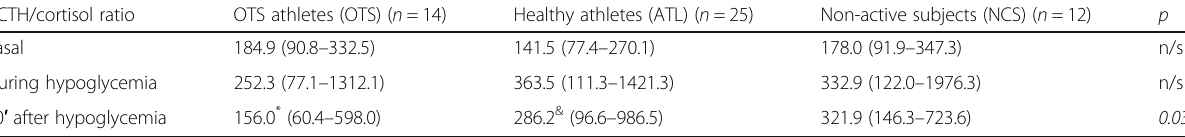
Table 4 Median (p95 confidence interval) ACTH/cortisol ratios during insulin tolerance test (ITT) ACTH/cortisol ratio